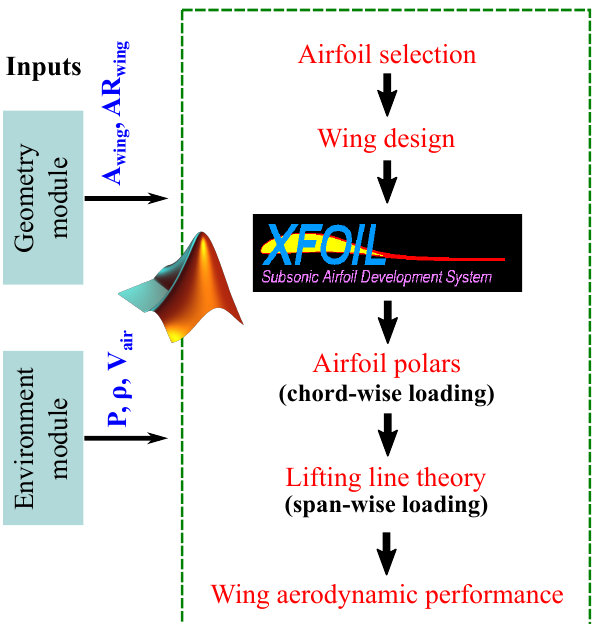
Figure 11. Scheme of the wing design process.